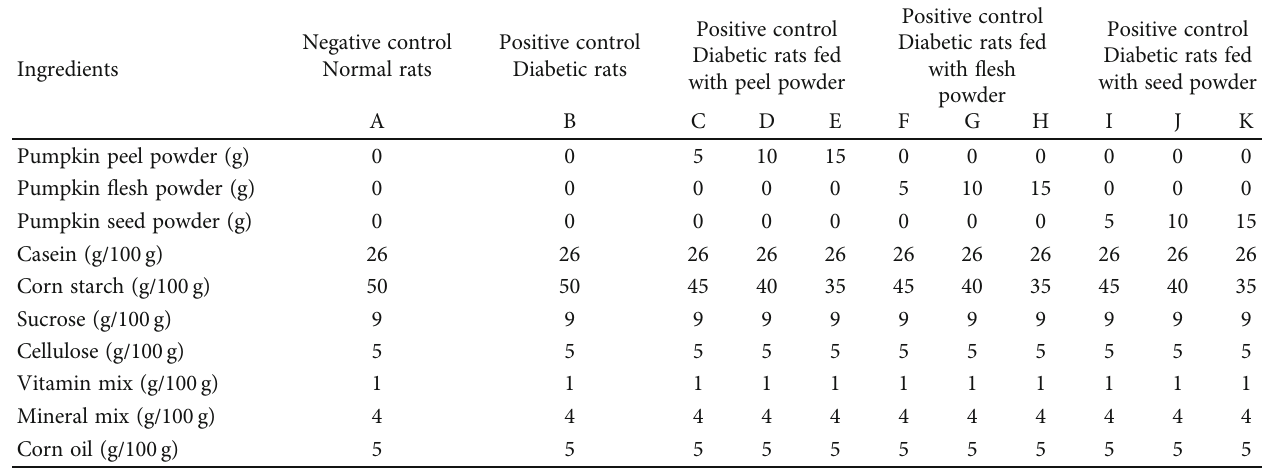
Table 1: Treatment plan for biological study of pumpkin peel, fl esh, and seed powders.